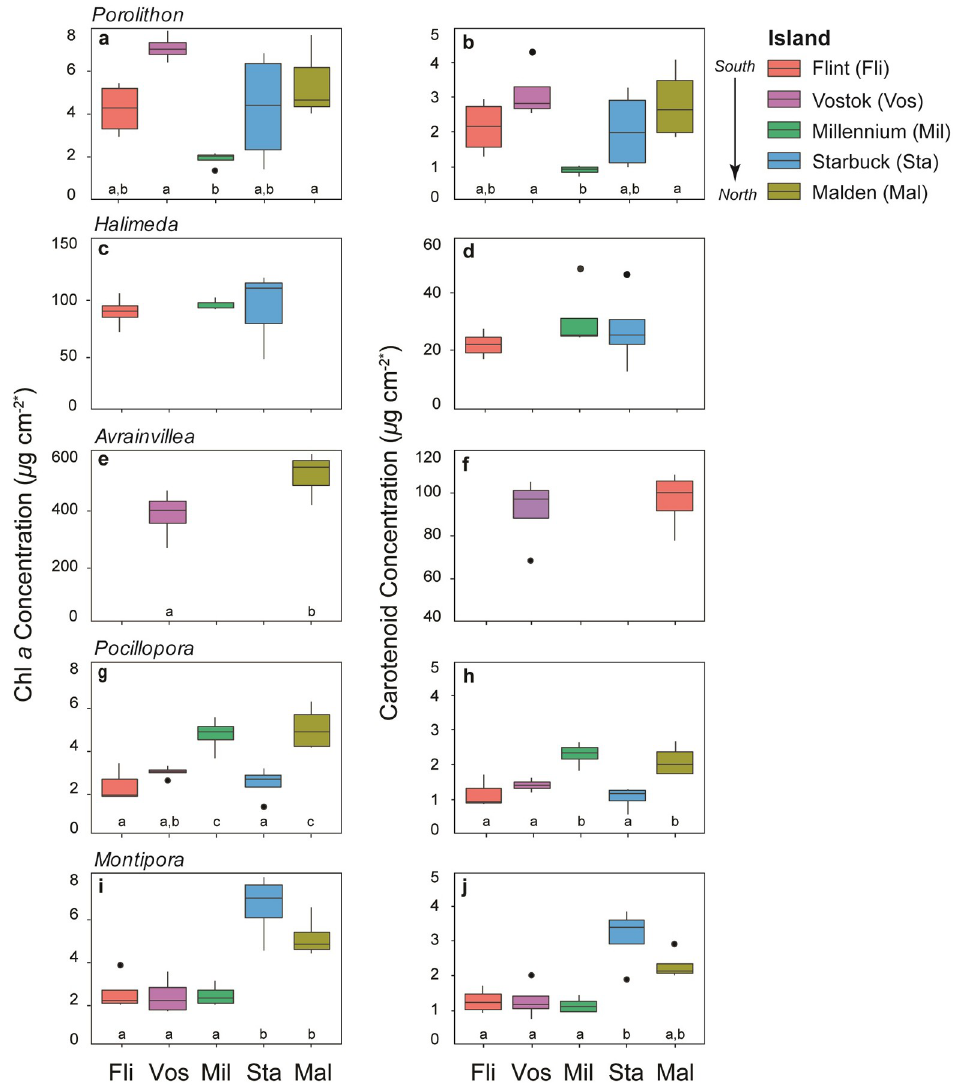
Fig 4. Photosynthetic pigments of corals and algae. Box plots of chl a and carotenoid concentrations in (a-b) Porolithon sp., (c-d) Halimeda sp., (e-f) Avrainvillea amadelpha , (g-h) Pocillopora meandrina , and (i-j) Montipora aequituberculata . Islands are ordered from south to north across the x-axis (from left to right), and missing bars indicate where a given species was not present at an island. Significant differences between islands were determined by Tukey’s HSD, different letters represent significant differences at p < 0.05. Porolithon and coral pigment concentrations were normalized to surface area, and rates are expressed as μ g cm -2 � . � Halimeda and Avrainvillea pigment concentrations were normalized to fresh weight, thus units for those taxa are μ g mg -2 .